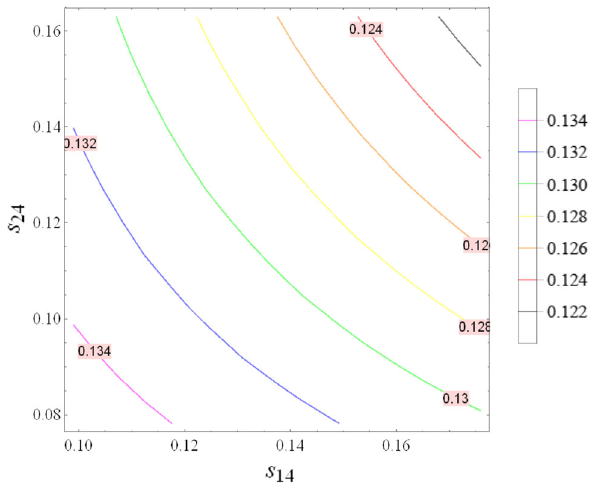
Fig. 2 s 34 versus U 14 , U 24 and U 34 with U 14 ∈ ( 0 . 099 , 0 . 176 ) , U 24 ∈ ∈ ( 0 , 0 . 197 ) ( 0 . 0775 , 0 . 161 ) and U 34